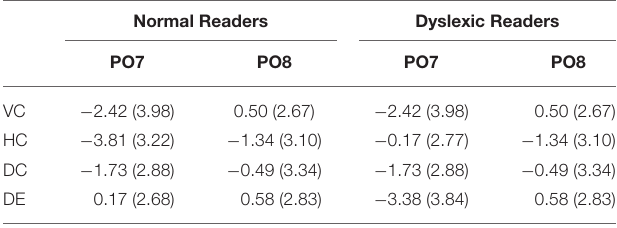
TABLE 2 | Mean (SD) ERP magnitude at PO7 and PO8 for four